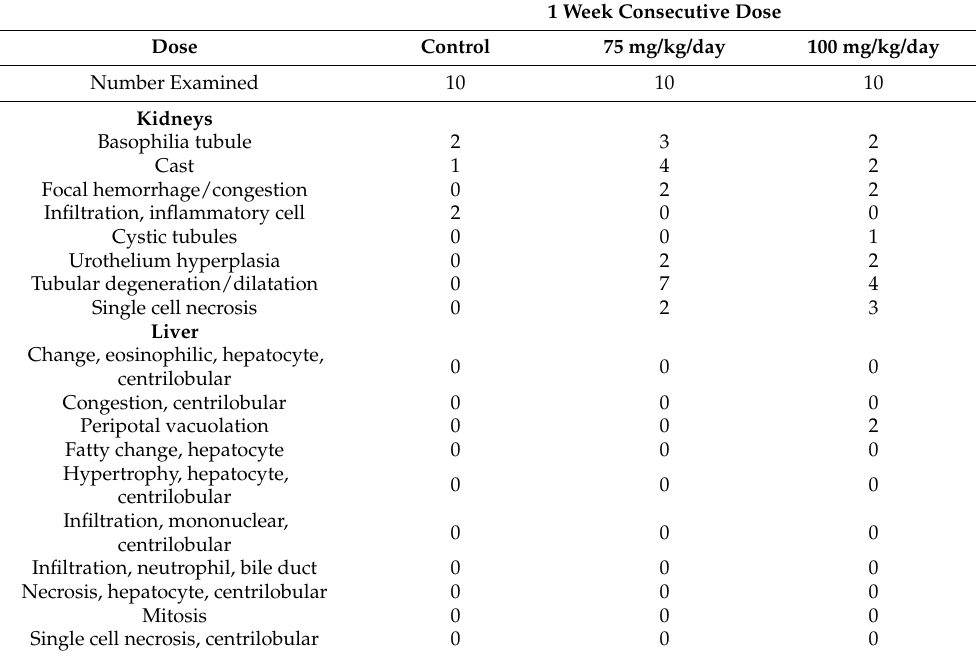
Table 5. Histopathological findings on 1-week consecutive ifosfamide-administered rats. 1 Week Consecutive Dose Dose Control 75 mg/kg/day 100 mg/kg/day